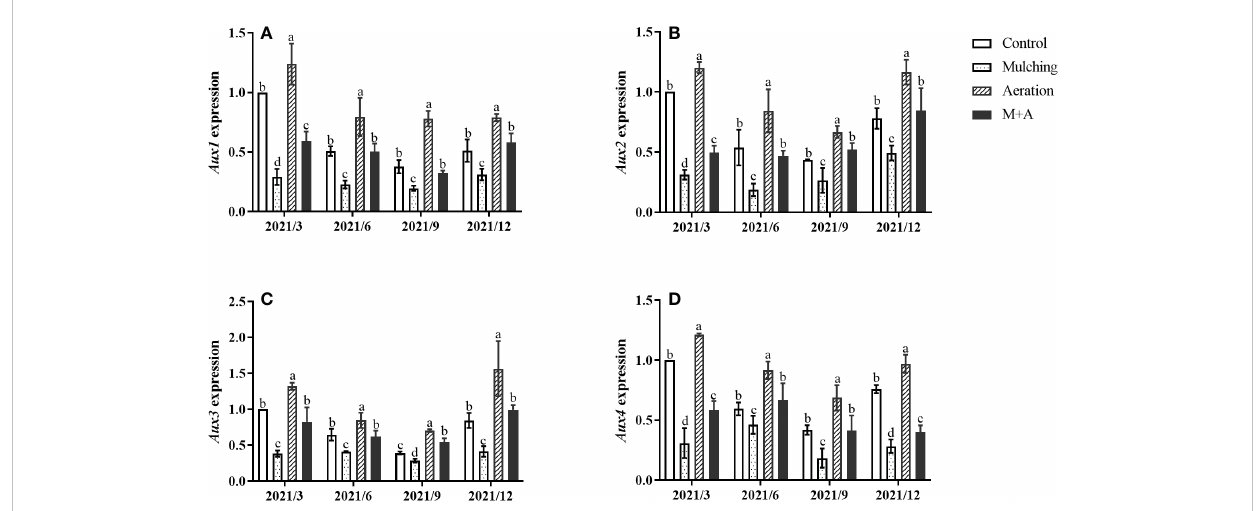
FIGURE 5 Effects of aeration on the expression of the Aux1 (A) , Aux2 (B) , Aux3 (C) and Aux4 (D) genes in the bamboo forest under mulching conditions (Control, Mulching, Aeration, M + A). The expression levels of PeNTB and Actin were used to normalize the expression for each sample. The vertical bars ± re fl ect the standard deviation of the mean. Different letters in the same period represent different signi fi cance ( p< 0.05).